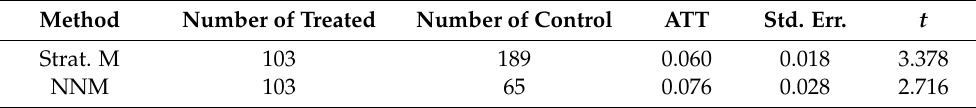
Table 7. Organic certification average treatment effect on the treated (ATT) (stratification and nearest neighbor matching (NNM)). Method